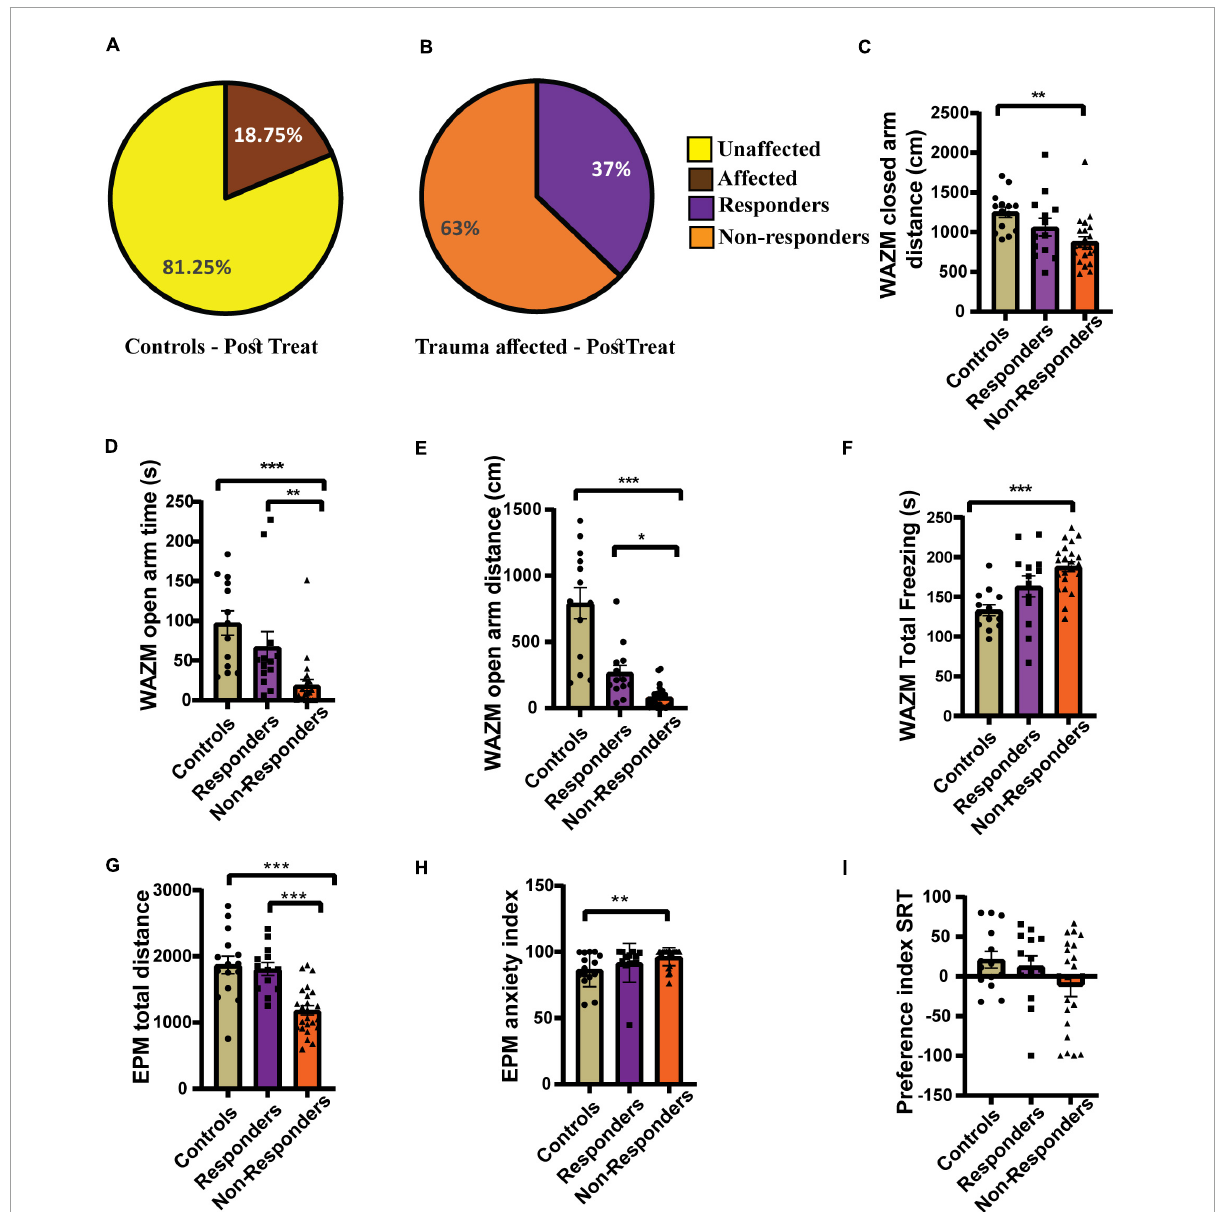
FIGURE7 Individual behavioral profiling 2 (IBP2) classified JVS+UWT affected animals as treatment responders and non - responders . (A) Percentage of affected and unaffected animals in the control group at the post-fluoxetine time point. (B) Percentage distribution of treatment responders and non - responders in the JVS+UWT affected group after fluoxetine treatment. (C) Distance travelled in the closed arms of the WAZM was less by the non - responders than the controls . [Kruskal–Wallis test H (3) = 12.42, ( p = 0.002); Dunn’s post-hoc test p ** < 0.01]. No statistical significance was found between responders and controls or non - responders. (D) Time spent in the open arms of WAZM was less by the non - responders than both controls and responders [Kruskal–Wallis test H (3) = 22.99, ( p < 0.0001); Dunn’s post-hoc test p ** < 0.01, p *** < 0.0001]. Responders had no significant difference with controls. (E) Distance travelled in the open arm of the WAZM was least by the non - responders while responders and controls covered similar distances [Kruskal–Wallis test H (3) = 29.21, ( p < 0.0001); Dunn’s post-hoc test p * < 0.05, p *** < 0.0001]. (F) Total time spent freezing in the WAZM was higher in the non - responders than controls . [Ordinary one-way ANOVA ( F ( 2 , 48 ) = 10.52, p = 0.0002); Bonferroni’s post-hoc test p *** < 0.0001]. No significant difference was observed in the time spent freezing in WAZM between responders and controls or non - responders . (G) Total distance travelled in the EPM was least in the non - responders while responders and controls spent similar distance [Ordinary one-way ANOVA ( F ( 2 , 48 ) = 17.23, p < 0.00001); Bonferroni’s post-hoc test p *** < 0.0001]. (H) Anxiety index in the EPM in the non - responders was higher than the controls [Kruskal–Wallis test H (3) = 10.85, ( p = 0.0044); Dunn’s post-hoc test p ** < 0.01]. No significant difference was observed between responders and controls or non - responders . (I)